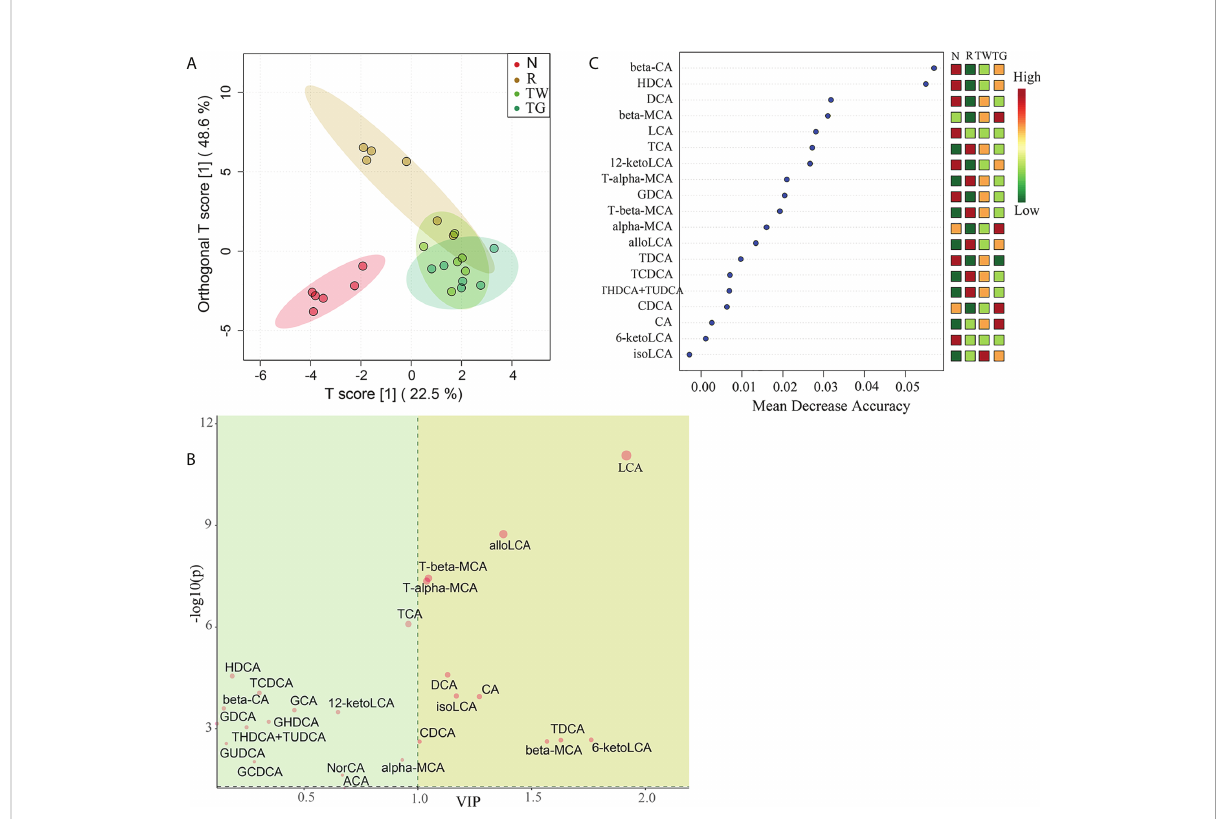
FIGURE 6 Differential bile acids (BAs) analysis of small intestine microbiota in the four groups. (A) Orthogonal partial least squares-discriminant analysis (OPLS-DA) scores plot. (B) OPLS-DA features. The dots in yellow area represent BAs with VIP >1 and P < 0.05. (C) Random forest analysis of BAs among the four groups based on mean decrease accuracy. The contents of each BA in different groups are represented by the shade of color. N, normal control group; R, antibiotic-associated diarrhea (AAD) restore group; TW, Qiwei Baizhu Powder (QWBZP) decoction group; TG, total glycosides of Qiwei Baizhu Powder (QWBZP-TG)